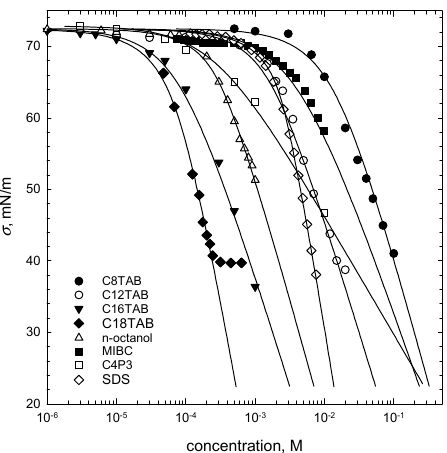
Figure 1. Surface tension isotherms (points) with the Frumkin model (Equation (1)) fitted to the experimental data (solid lines). The parameters of the fitted Frumkin isotherms are listed in Table 2. Table 2. Parameters of the Frumkin isotherm (Equation (1)) fitted to experimental data. Surface-Active